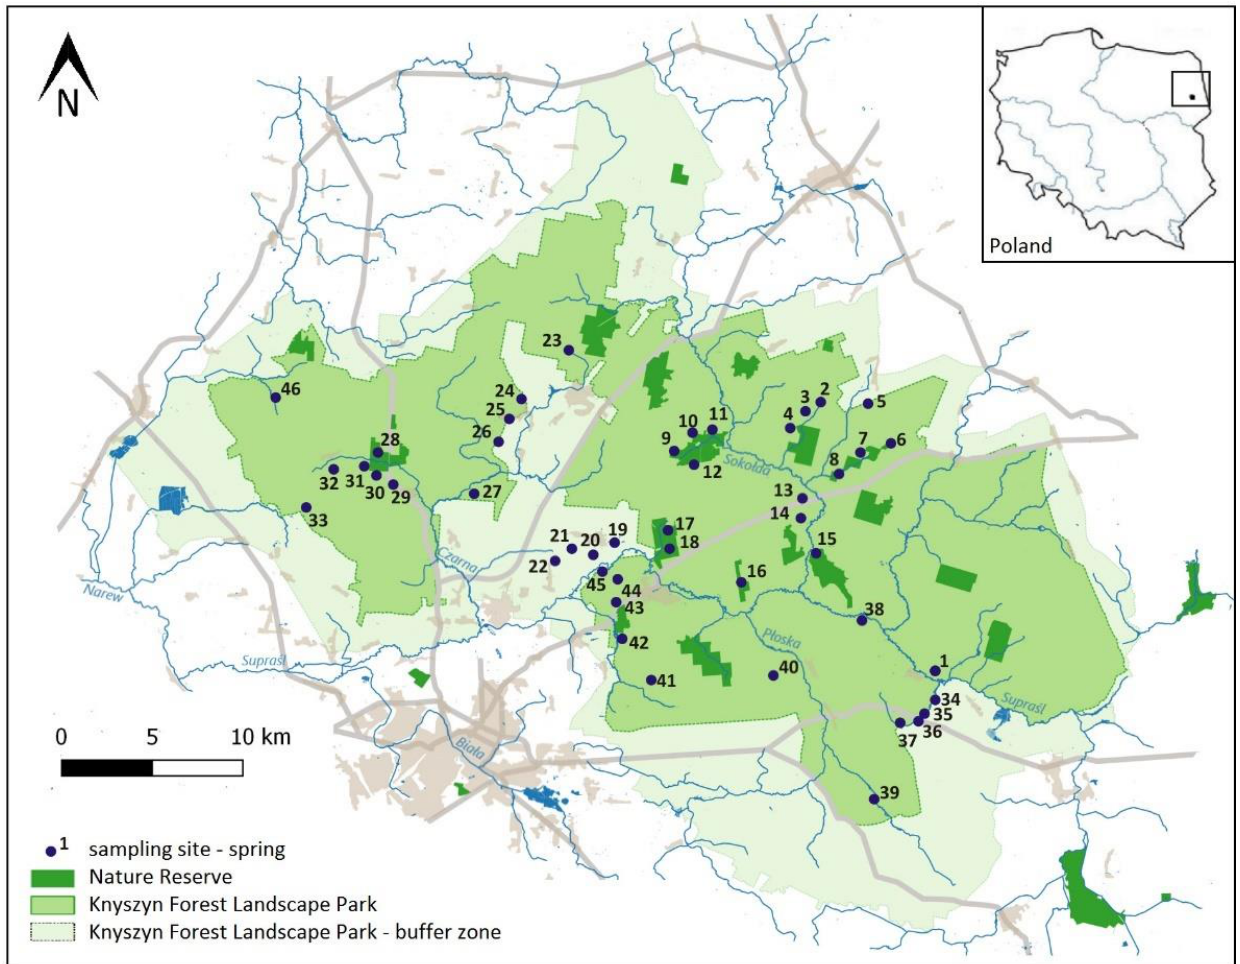
Figure 1. Locations of the studied springs in the Knyszyn Forest.